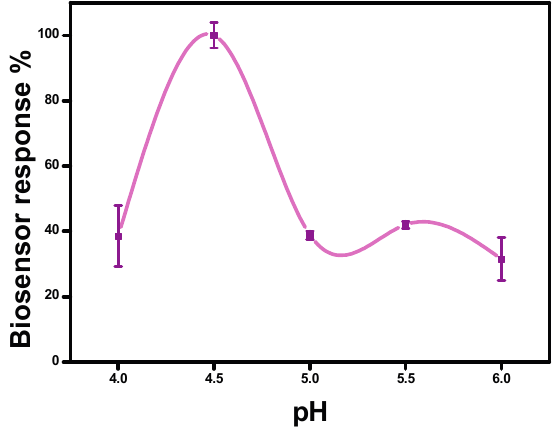
Figure 4. Effect of pH (in sodium acetate buffer, 50 mM, at pH 4.0–5.5 and in sodium phosphate buffer at pH 6.0; SNS-NH 2 /SNS-NH 2 -Fc: 0.5/4.5 mg; +0.45 V, [Glucose]: 5.0 mM). Error bars show standard deviation.